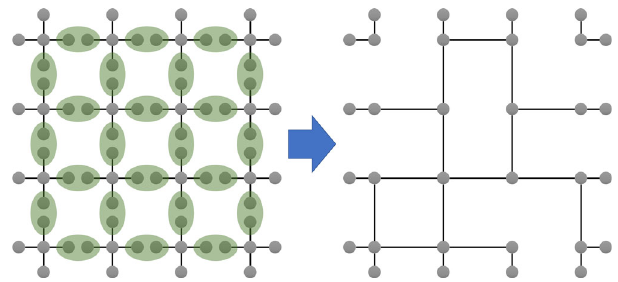
Fig. 1 Creating a percolated square lattice with fusion. Fusing fi ve-photon star clusters into a percolated 2D square lattice is possible with two-qubit fusion operations, if each fusion attempt succeeds with the probability more than 0.5, the bond-percolation threshold of the lattice